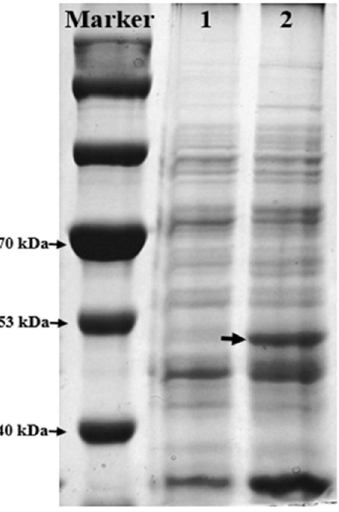
Figure 2. SDS-PAGE analysis of m L -AAD expression in BL21(DE3)-pET-28a- mlaad . Lane 1 , membrane fractions of BL21(DE3)-pET28a (control); lane 2 , membrane fractions of BL21(DE3)-pET-28a- mlaad ; The same amounts of cells were loaded in lane 1 and lane 2. Bands indicated by arrow, recombinant m L -AAD; the theoretical protein size was 51.5 kDa. Both BL21(DE3)-pET-28a- mlaad and the control were induced using 0.5 mM IPTG at 28 °C and 150 rpm for 6 h.